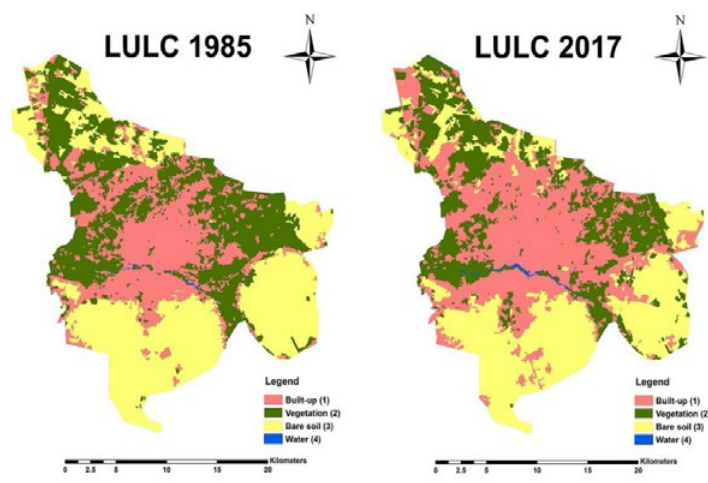
Fig. 2: Land use‐Land cover maps of 1985 and 2017 in Isfahan Fig. 2. Land use-Land cover maps of 1985 and 2017 in